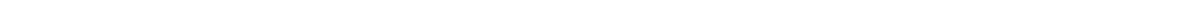
Fig. 3 Lamin A/C-dependent differential formation of an actin cap and nuclear deformation in response to substrate stretching. a – f Representative F-actin organization and nuclear morphology of lamin A/C-present WT ( a – c ) and lamin A/C-de fi cient Lmna − / − ( d – f ) MEFs at different time points of the substrate stretching (0, 30, 60 min). Insets display details of F-actin organization in the apical region of the nucleus. Full and empty arrowheads indicate the presence and absence of the perinuclear actin cap, respectively. Nuclear morphology of lamin B1-stained nuclei (yellow) indicates distinct evolution of 3D-nuclear shape in response to substrate stretching, where maximum intensity projection onto the XY -plane was performed using upper hemispheres of the 3D- reconstructed nuclei to highlight the detailed nuclear surface texture. The cross-sectional side view was captured along the XZ -plane crossing the center of the nucleus. g – k Stretch-dependent formation of an actin cap ( g ) and changes of nuclear volume ( h ), thickness ( i ), lateral bumpiness ( j ), and surface roughness ( k ) in WT (blue) and Lmna − / − (red) MEFs. Note that nuclear fl attening with volume conversation ( h , i ) and nuclear surface roughening with volume reduction ( j , k ) are the stretch-induced characteristic features of the actin cap forming WT and actin cap non-forming Lmna − / − cells ( g ). In i and k , nuclear thickness was de fi ned as the maximum height in the vertically cross-sectioned image of the 3D-reconstructed lamin B1-stained nucleus and the height variation along the apical surface was termed as surface roughness. In g , > 150 cells were examined per condition and in h – k , > 30 lamin B1-stained nuclei were analyzed per condition. Error bars represent the S.E.M. of averaged values. Unpaired t -test was applied to compare unstretched control cells (0 min) and fully stretched cells (60 min). *** p < 0.0001, ** p < 0.001, NS not signi fi cant ( p >